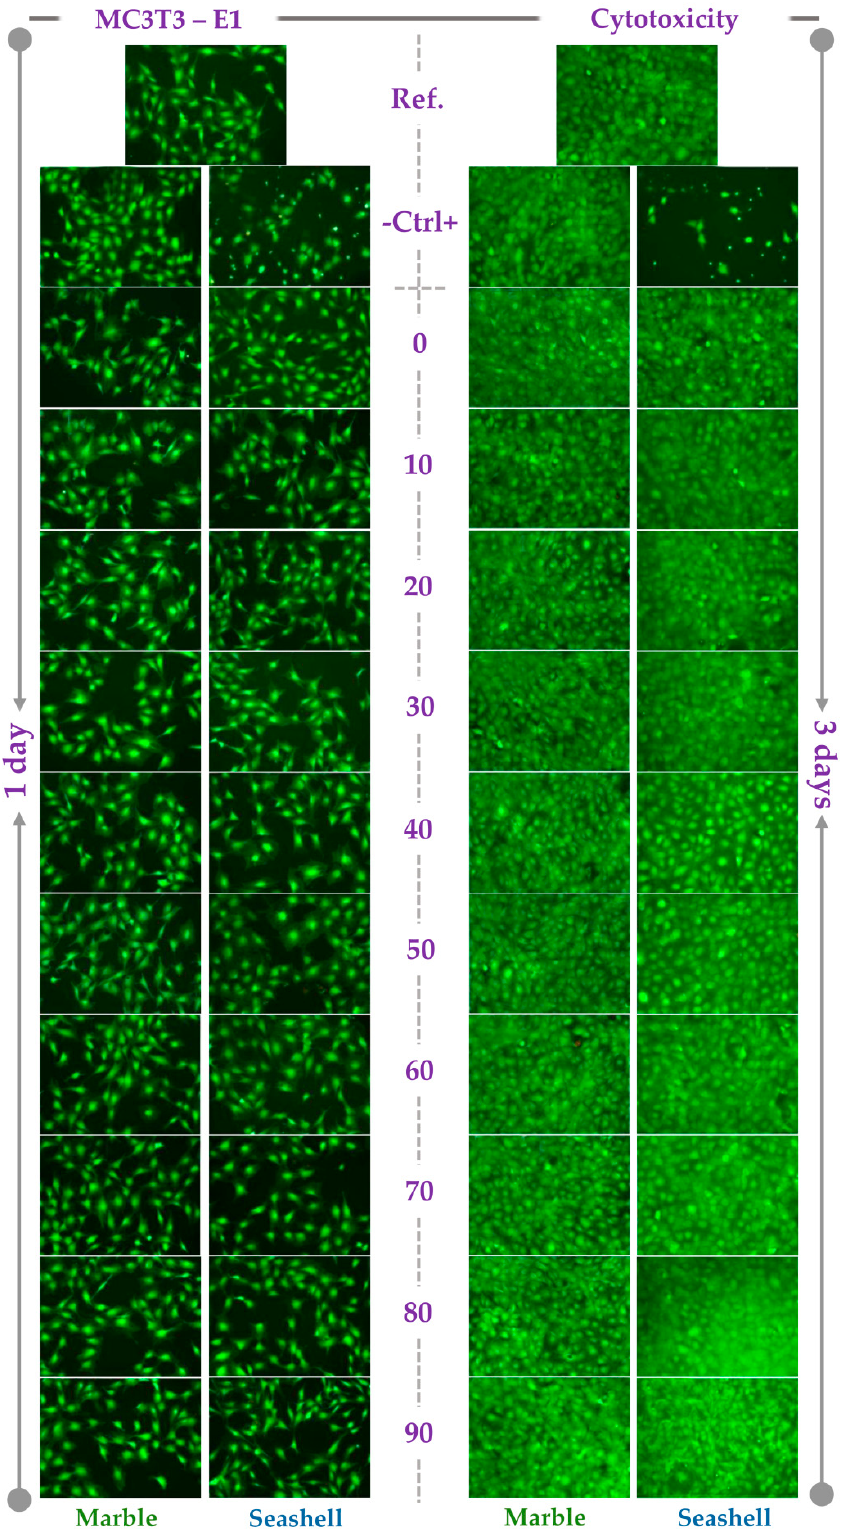
Figure 6. Fluorescence micrographs of the MC3T3-E1 pre-osteoblasts grown in the extracts of marble and seashell-derived powdered samples for 1 day and 3 days. Cell staining with the LIVE/DEAD Cell Viability/Cytotoxicity Assay Kit (green fluorescence: live cells; red fluorescence: dead cells). Scale bar: 100 μ m.